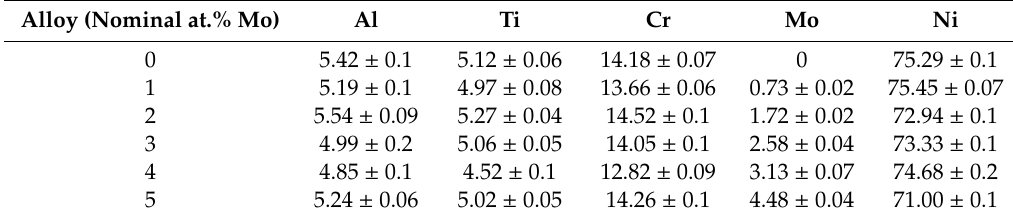
Table 1. Average bulk composition of each of the model alloys, as determined experimentally by SEM EDX.